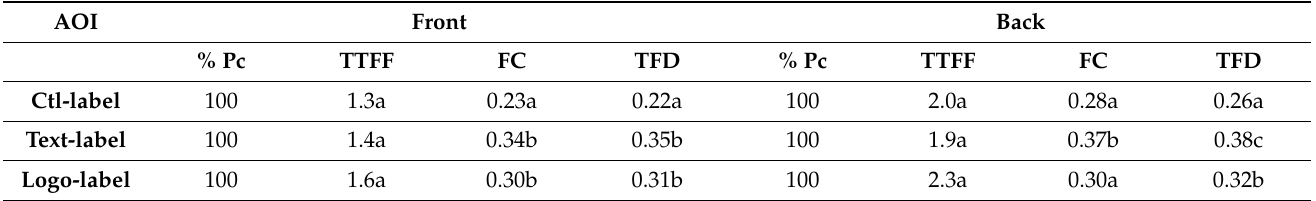
Table 3. Eye-tracker metrics for the AOI-label. % Pc- percentage of participants, TTFF-time for first fixation, FC-fixation counts, TFD-total fixation duration. TTFF is expressed as seconds. FC and TFD are relative values (sec) after normalizing